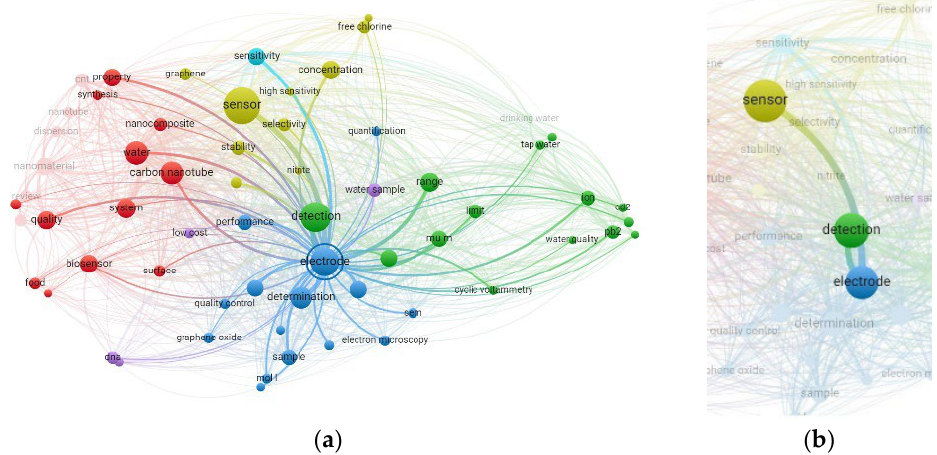
Figure 7. ( a ) Cluster 3 Network—“electrode” main keyword. ( b ) “electrode-sensor-detection” linking Table 6. Cluster 3 keywords and occurrences. Table 6. Cluster 3 keywords and